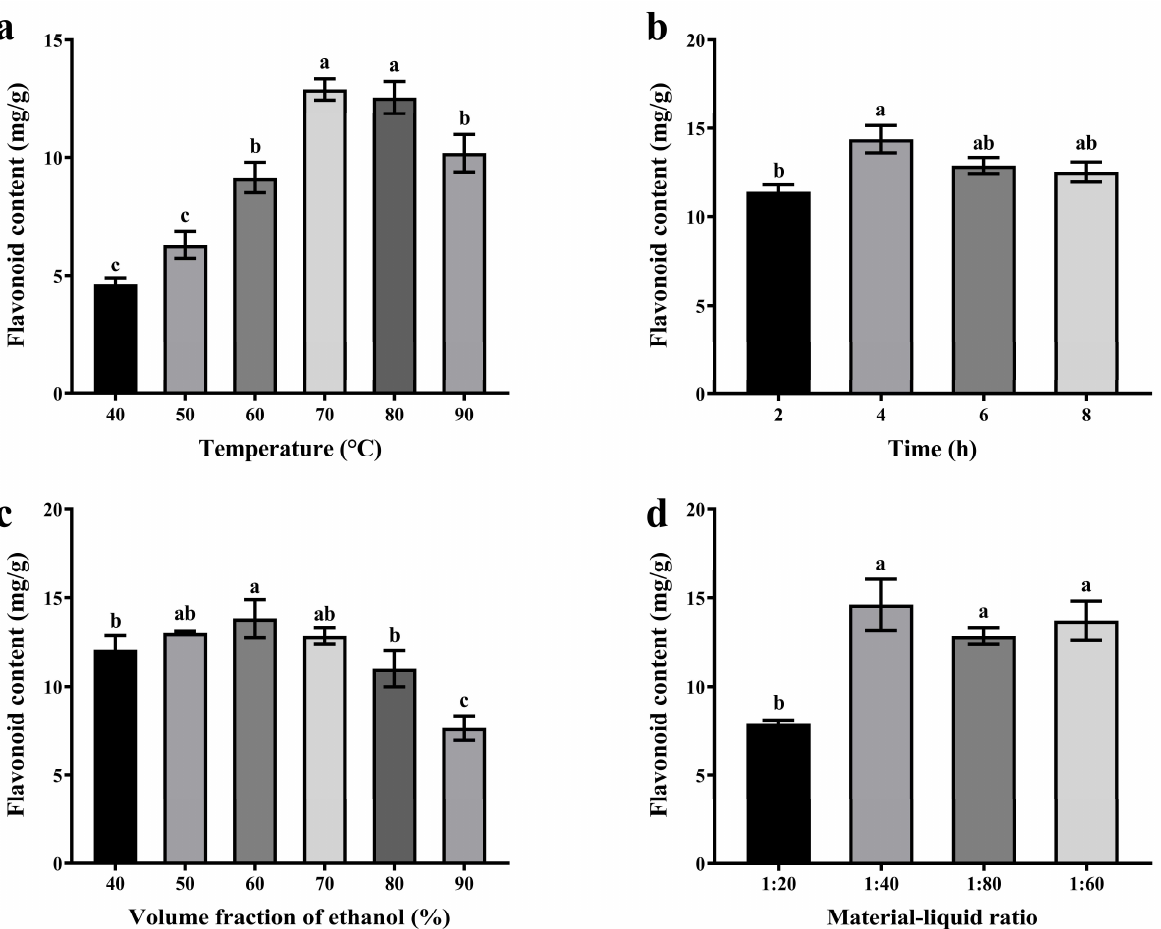
Figure 1. The effects of various factors on extraction of total SHFs from mycelia: ( a ) temperature (°C); ( b ) time (h); ( c ) ethanol volume fraction (%); and ( d ) material – liquid ratio ( w / v ). Differing letters above bars indicate significant ( p < 0.05) differences according to Tukey’s multiple comparisons test.